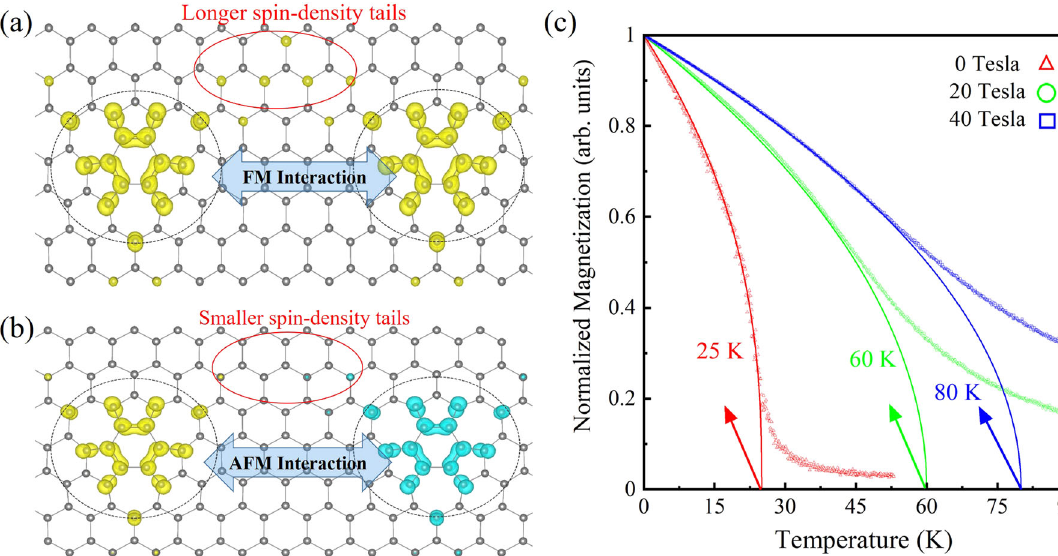
Fig. 3 Long-range ordering and magnetization density for C 2 . The a FM and b AFM spin con fi gurations, with iso-surface values of ±0.005eBohr − 3 , the gold, and cyan colors represent the up and down spin, c MC calculations of mean magnetization as a function of temperature. Table 1. The magnetic properties of C 2 .